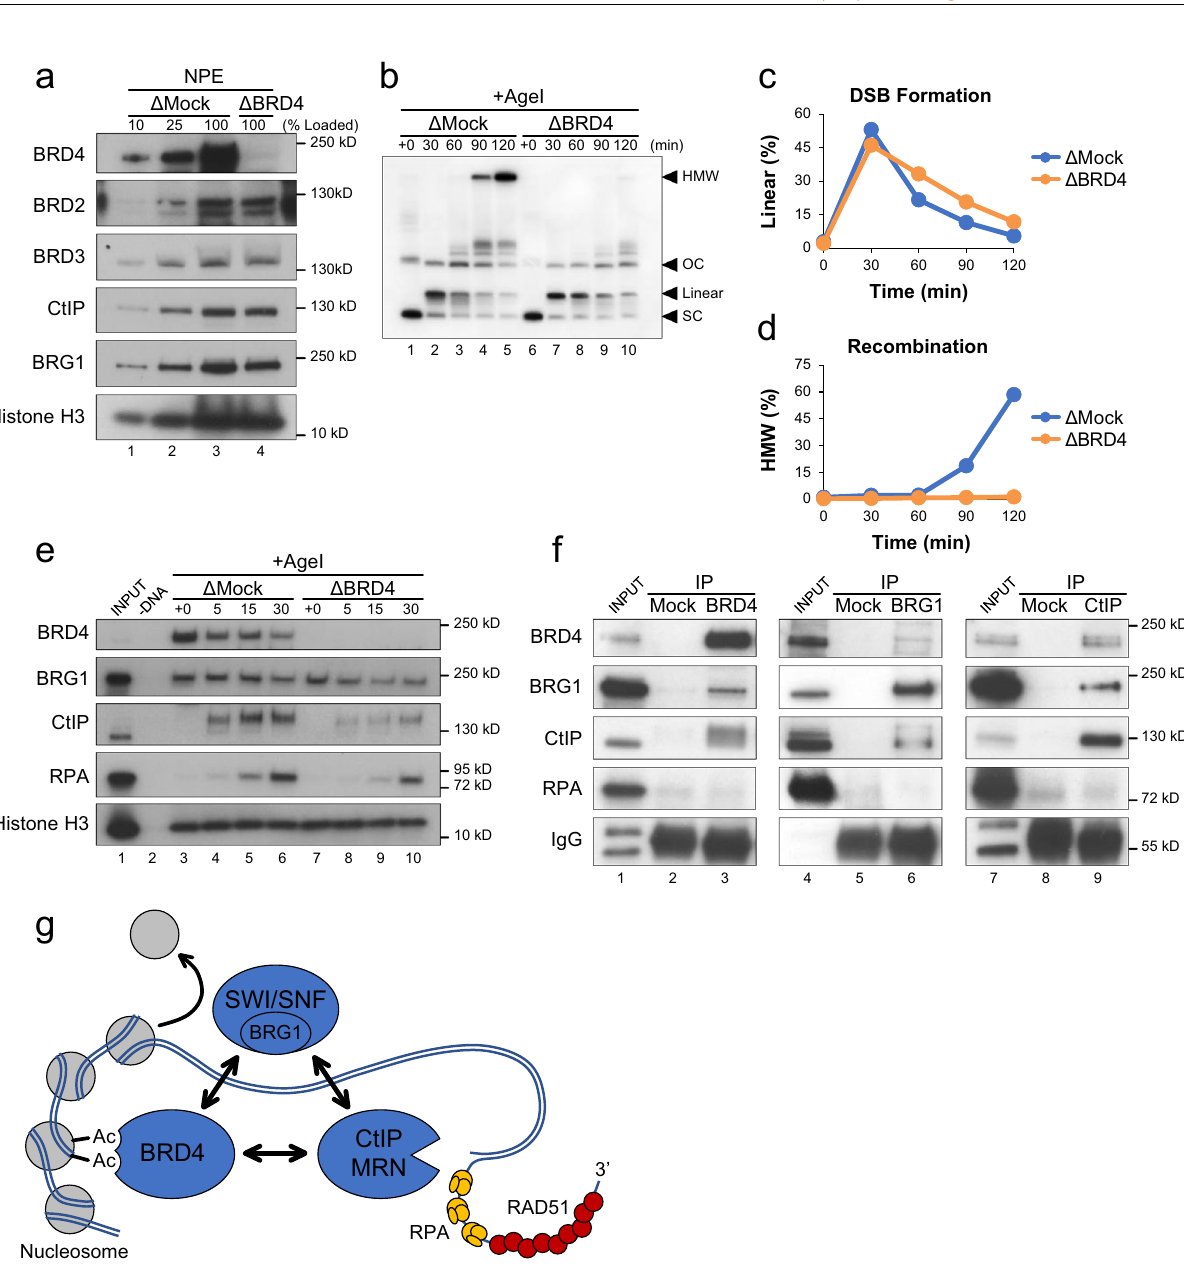
graphed relative to the + Buffer or Δ Mock control.